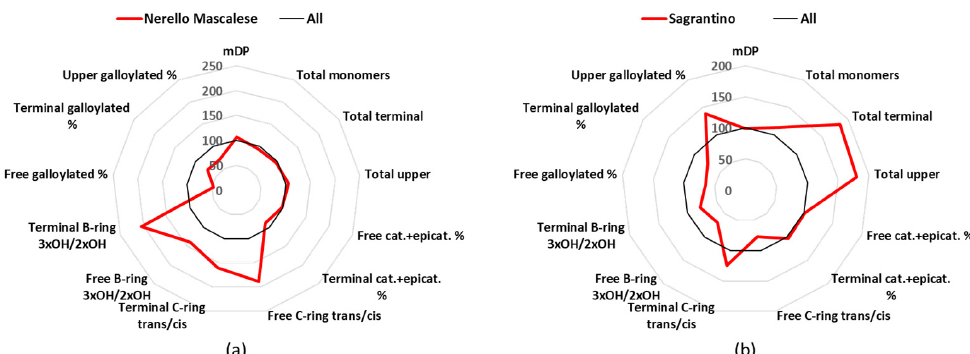
Figure 7. Radar graph comparing the percentage of the relative mean values of Nerello Mascalese ( a ) and Sagrantino ( b ), with the mean values of the 12 groups considered as 100%. cat.: catechin, epicat: epicatechin.